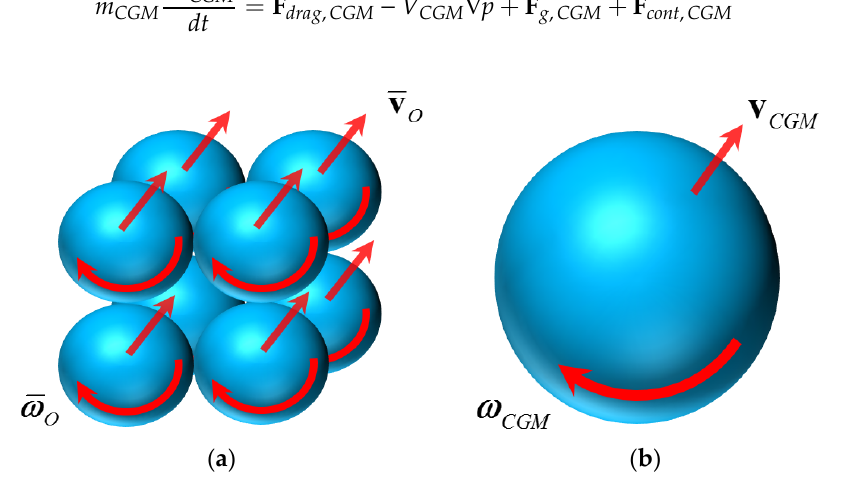
Figure 1. Illustration of the coarse graining process (coarse grain ratio l = 2). ( a ) Original particles; ( b ) Coarse grain particle (particle-group).